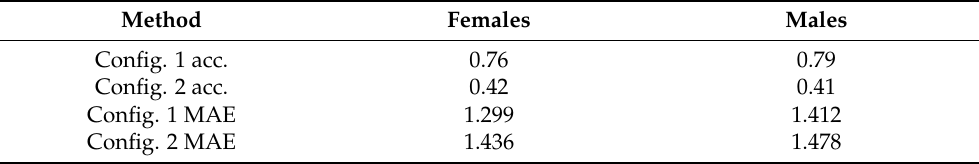
Table 7. With and without cross-stage strategy performance